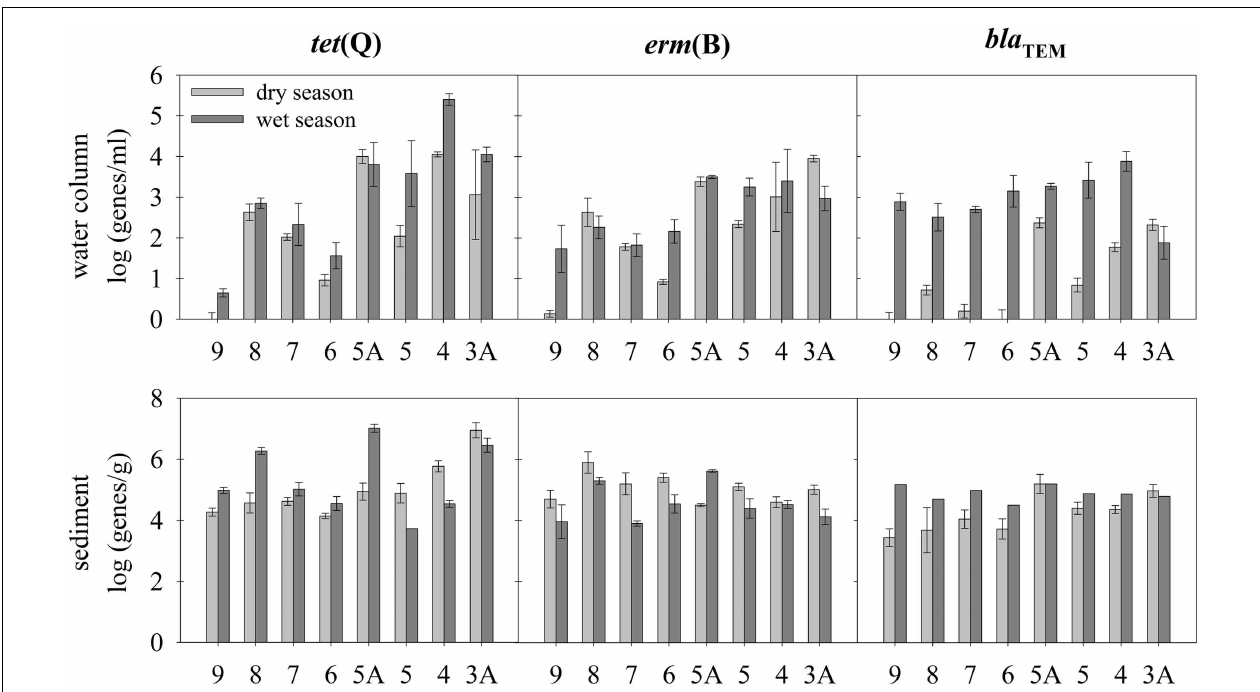
FIGURE 3 |Water column (per mL) and sediment (per g-sediment) gene abundance of exemplar genes [ tet (Q), bla TEM , and erm (B)] in theAlmendares River.